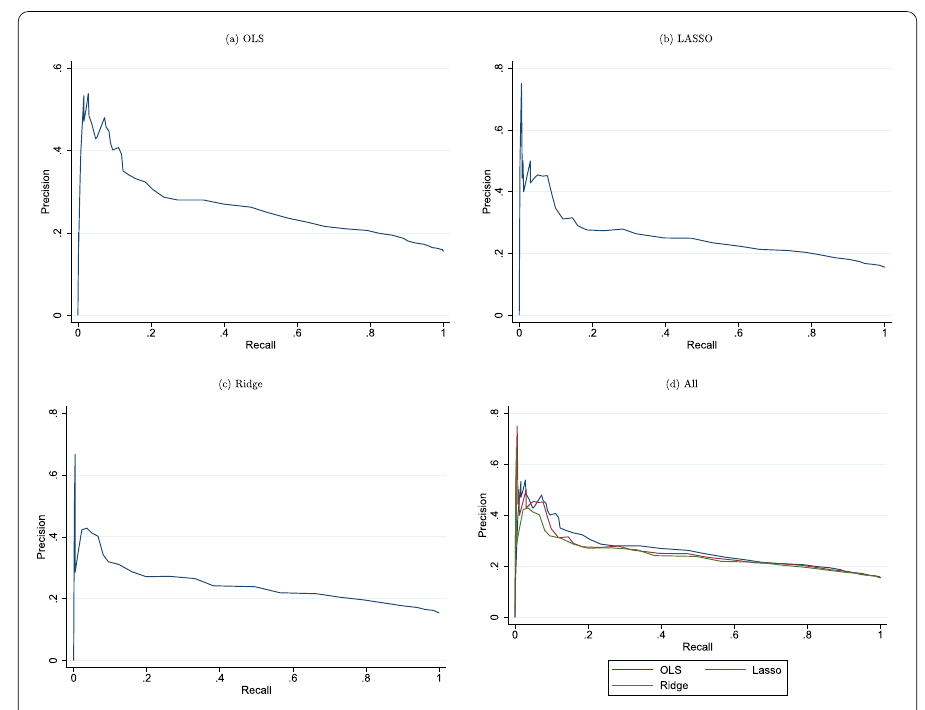
Figure A.3 Precision and recall curves. Large model—verification data